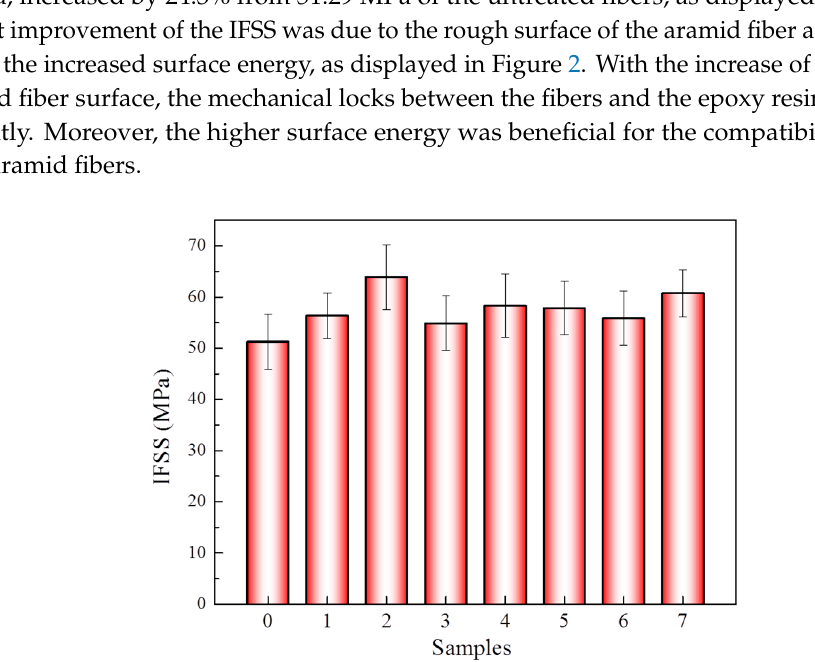
Figure S1: SEM images of aramid fiber surface morphology before and after treated with pure scCO 2 . (a) Untreated fiber; (b) modified fiber with pure scCO 2 under the same condition of sample 2 in Table 1, the scale bar was 2 µ m. Figure S2: C1s spectrum and concentrations of correlative functional groups of modified fibers of sample 2 in Table 1 after ion etch for 60